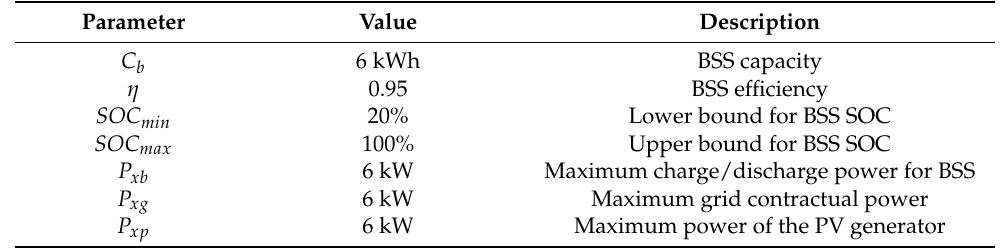
Table 2. Electrical system